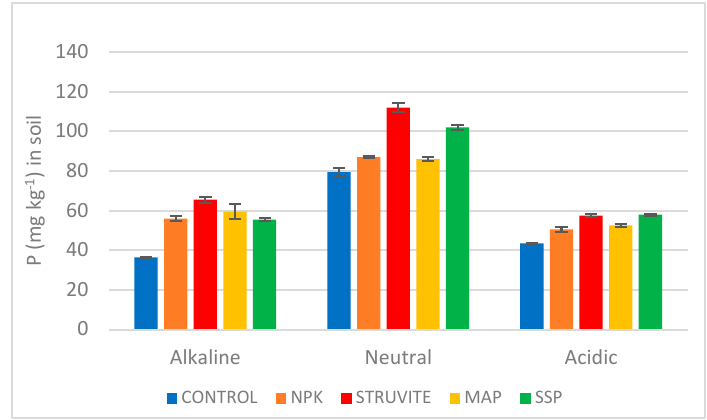
Figure 3. Available P content (mg/kg) in soils after leaching assay. Table 5. Physicochemical characteristics of soils after leaching assay. Values followed by different letters indicate significant differences ( p < 0.05, Duncan’s test). DL: detection level.